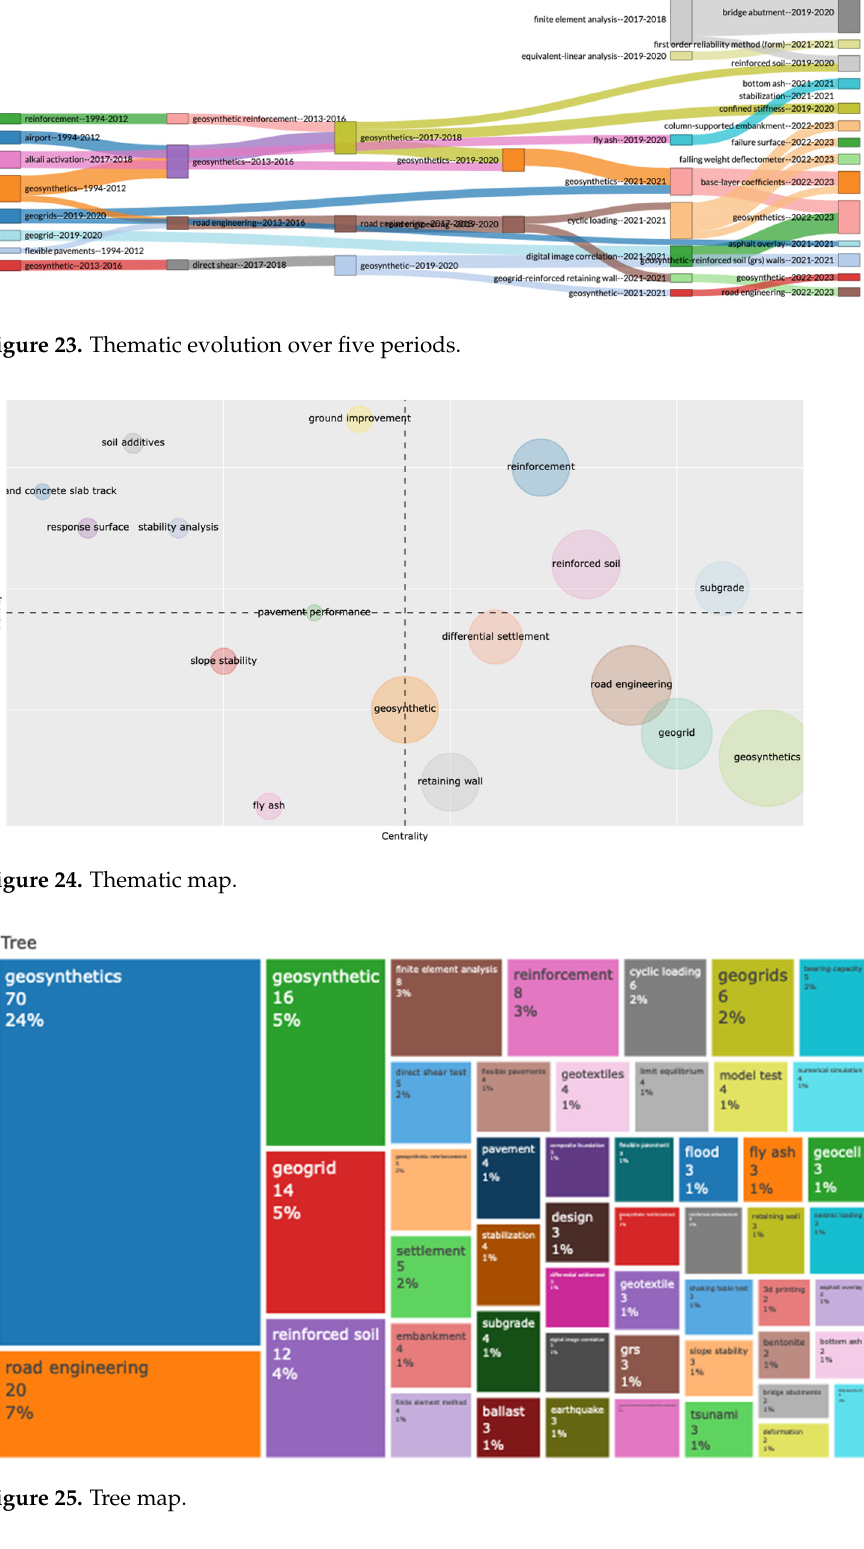
Figure 25. Tree Figure 25. Tree map.